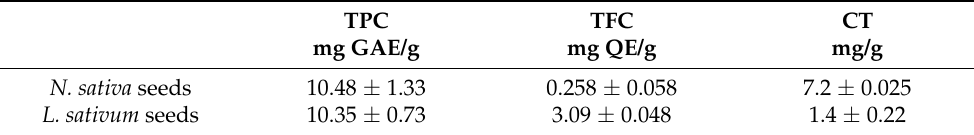
Table 2. Phytochemical content of both seed